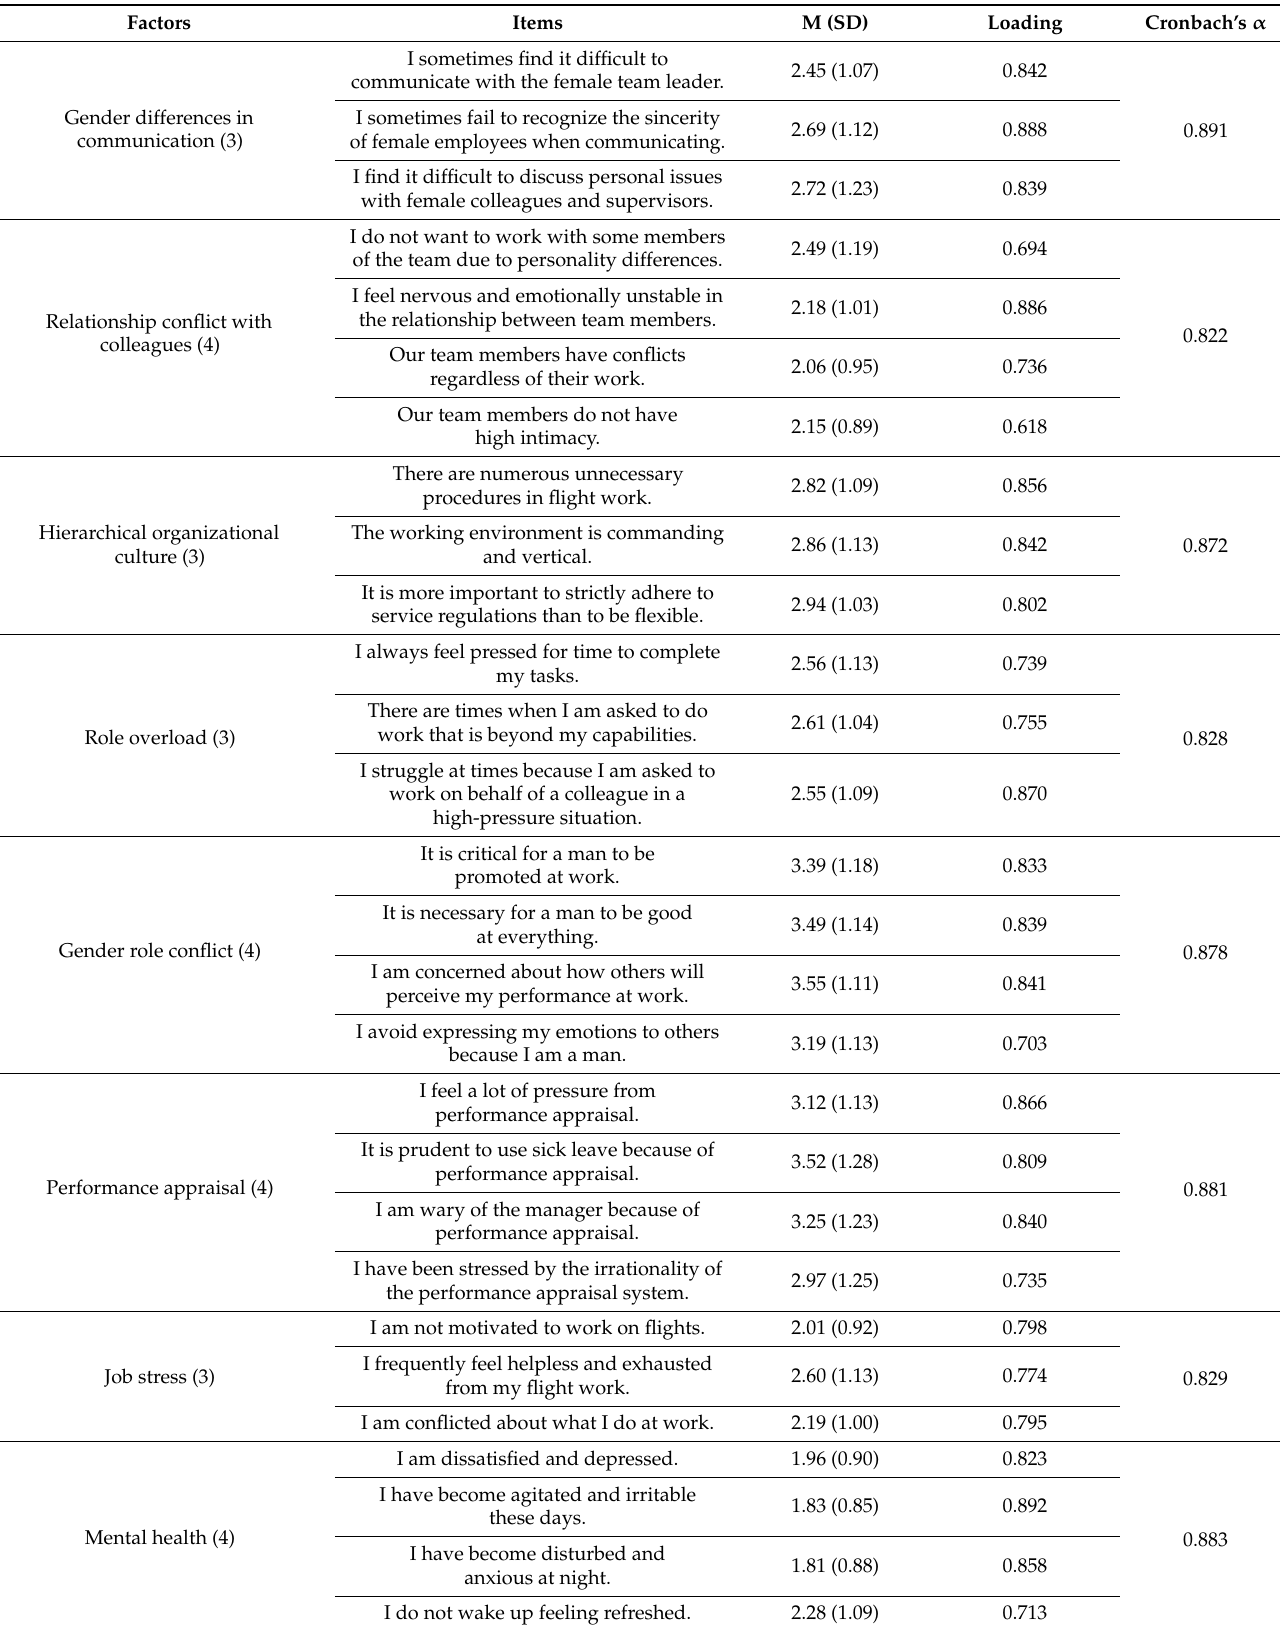
Table 2. Confirmative factor analysis and reliability analysis